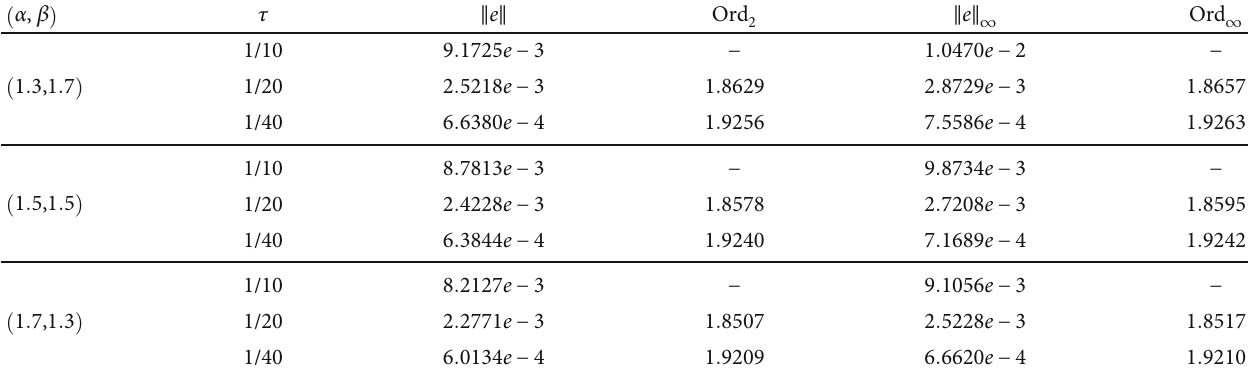
Table 6: l 2 -and l ∞ -errors and their convergence orders of (28) – (30) for 1 < α < 2 in the temporal direction for (75) with h = 1/1000 for Example 3.